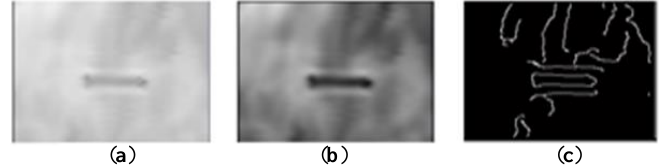
Figure 21. Images of notch 1 under the 2 mm-thick rubber layer: ( a ) original and after ( b ) average filtering, ( c ) the canny edge detection algorithm obtained at a standoff distance of 0.1 mm.